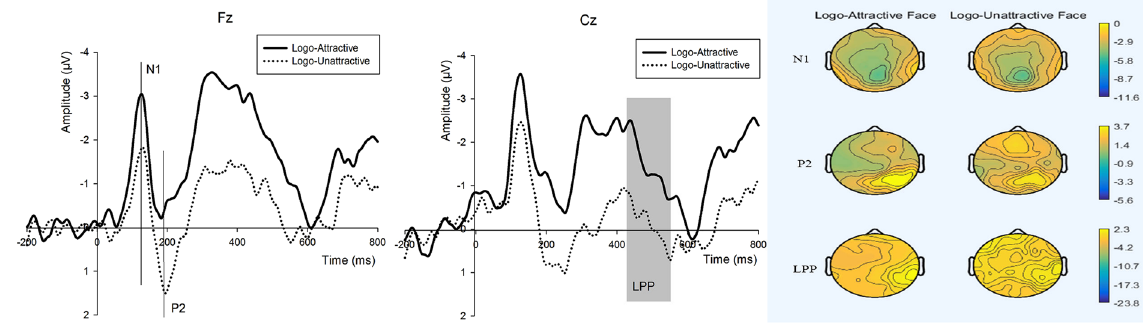
Figure 2. Wavefroms and brain topographic maps of N1, P2 and LPP of logo onset in experiment 1. Fz and Cz were chosen to